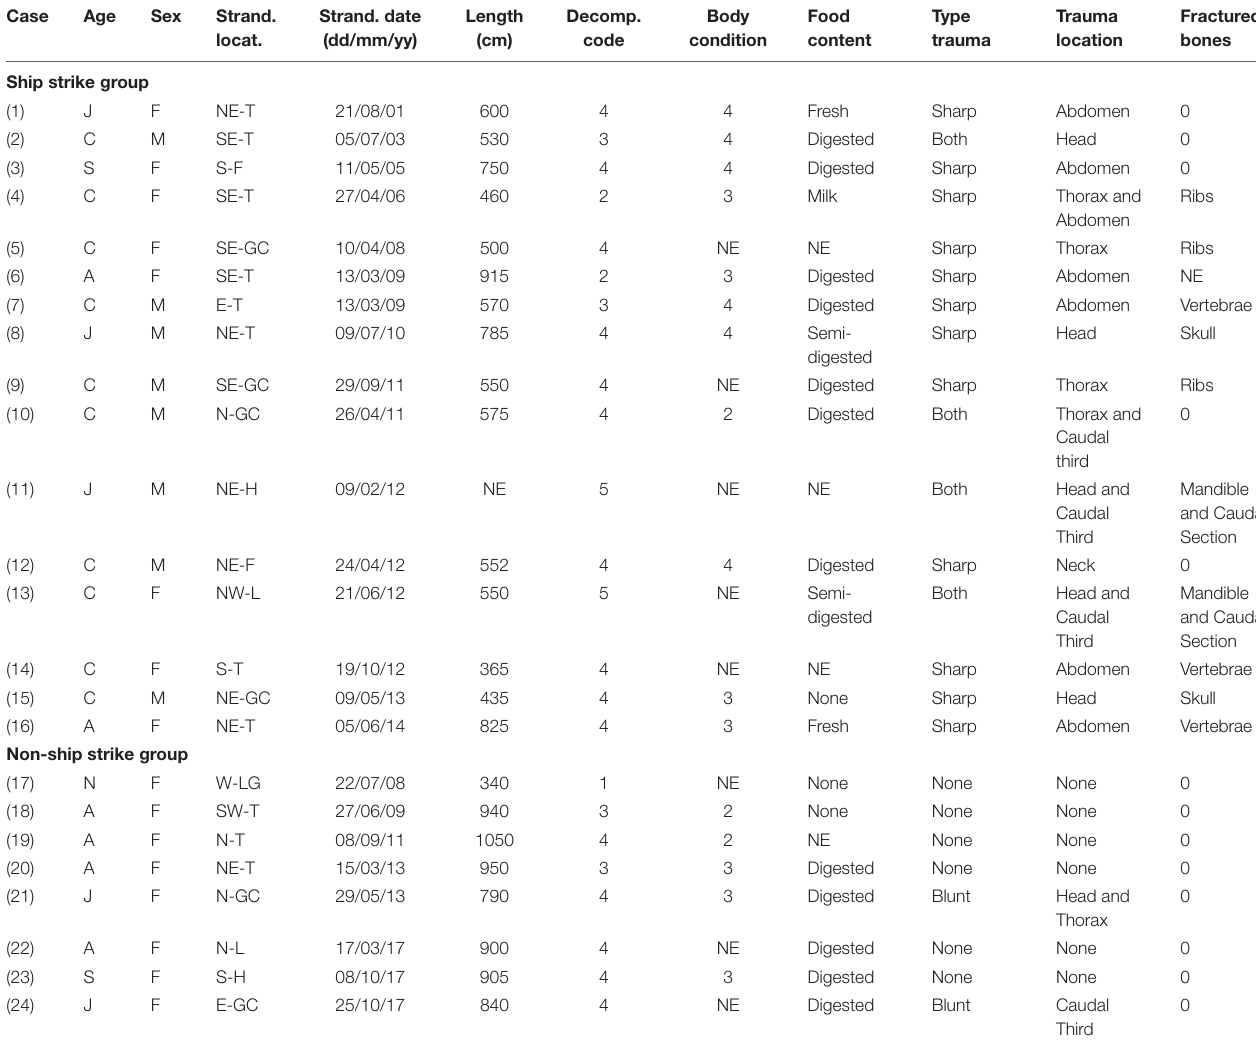
TABLE 1 | Epidemiological and biological data of the sperm whales included in the present study with evidence of ship strike. Case Age Sex Strand.